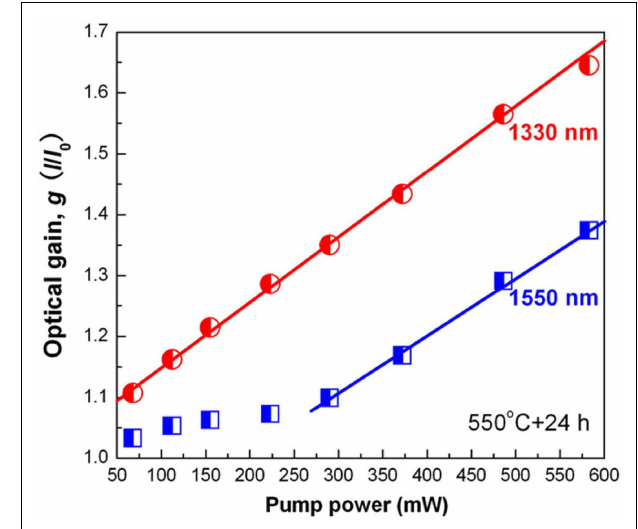
FIGURE 17 | Optical gains ( I / I 0 ) at 1330nm (red) and 1550nm (blue) of PbS QD-doped glass heated at 550°C for 24h, which are collected as a function of pumping power (Guoping et al., 2014) .